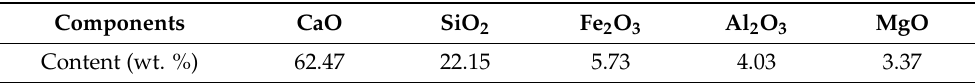
Table 1. The primary chemical components of silicate cement powder.